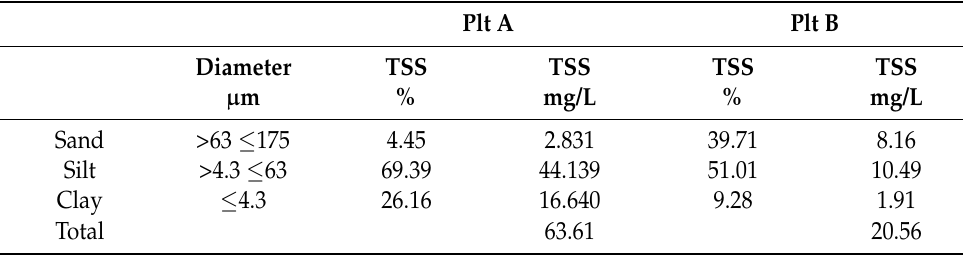
Table 4. Characterization of TSS in the PW for platform A and